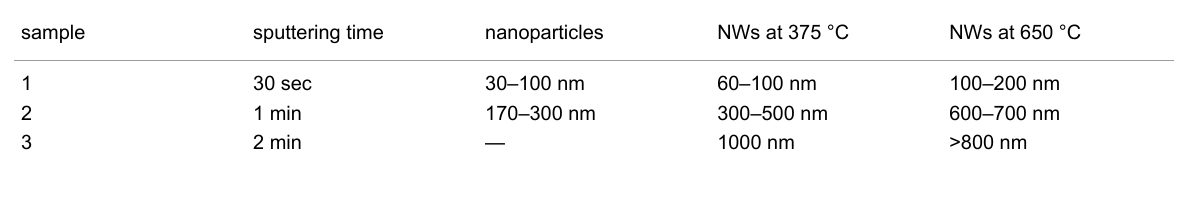
Table 1: Size distribution of the NWs obtained at different temperatures, grown on sputtered gold films of different thickness that had been annealed at 650 °C before the NW formation.